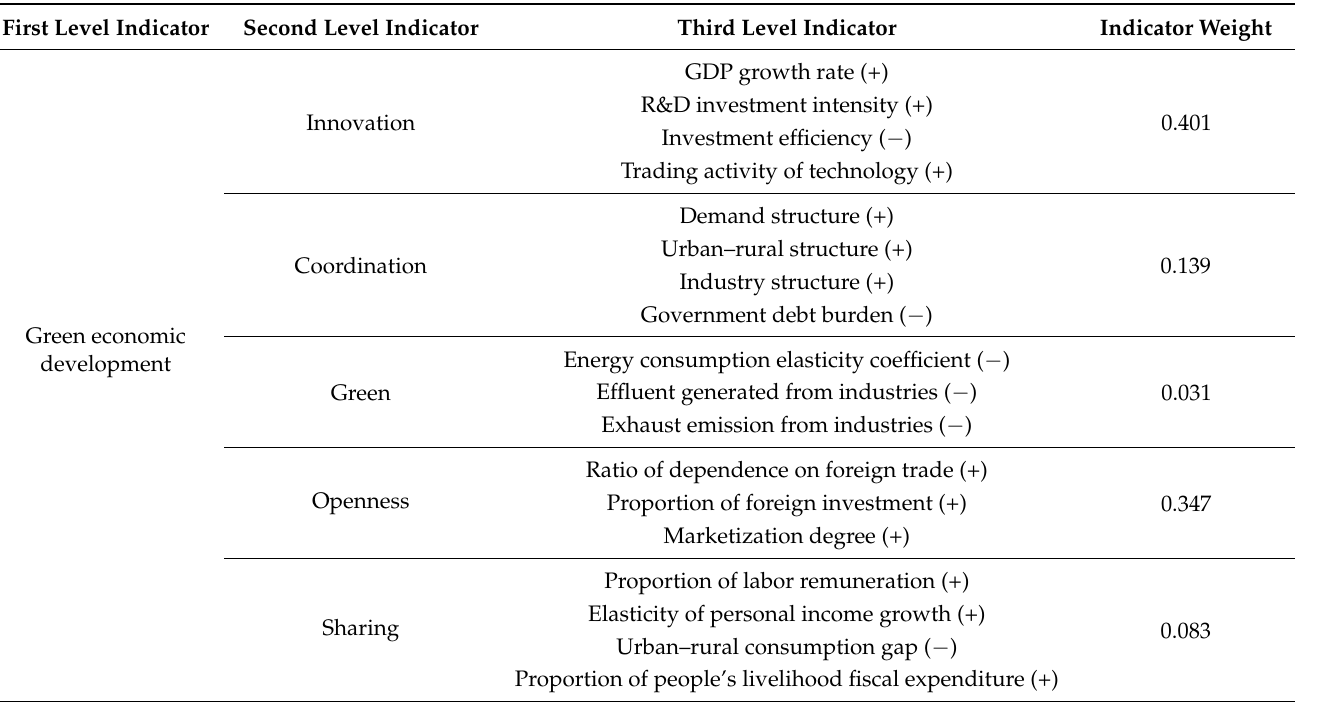
Table 3. Index selection and weight for green economic